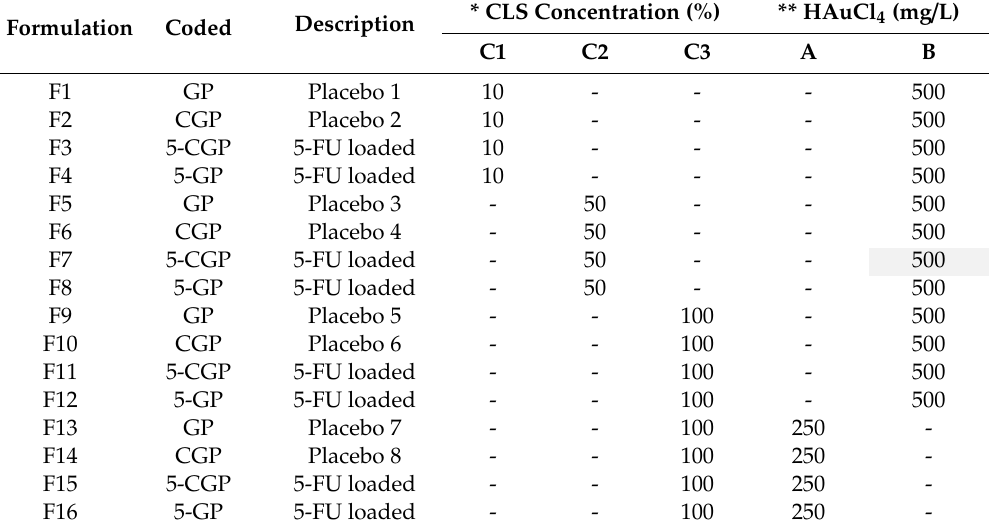
Table 1. Developed 5-FU (1% w / v ) loaded gold nanoparticles and placebo with varied concentrations of CLS (%) and HAuCl 4 (mg /